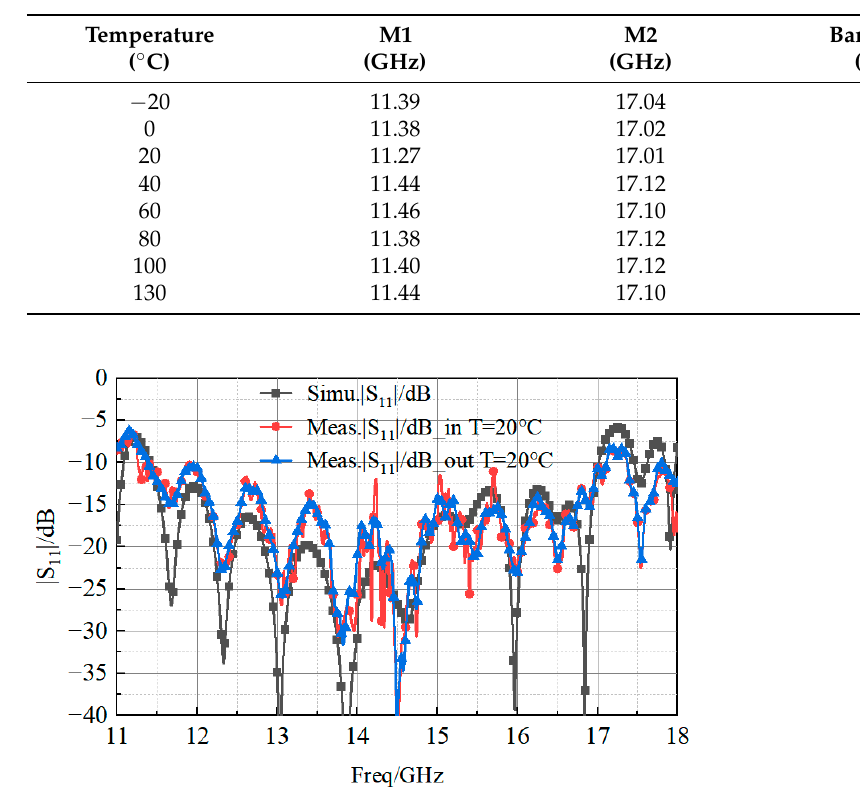
Table 2. Measurement of the antenna bandwidth at di ff erent temperatures.